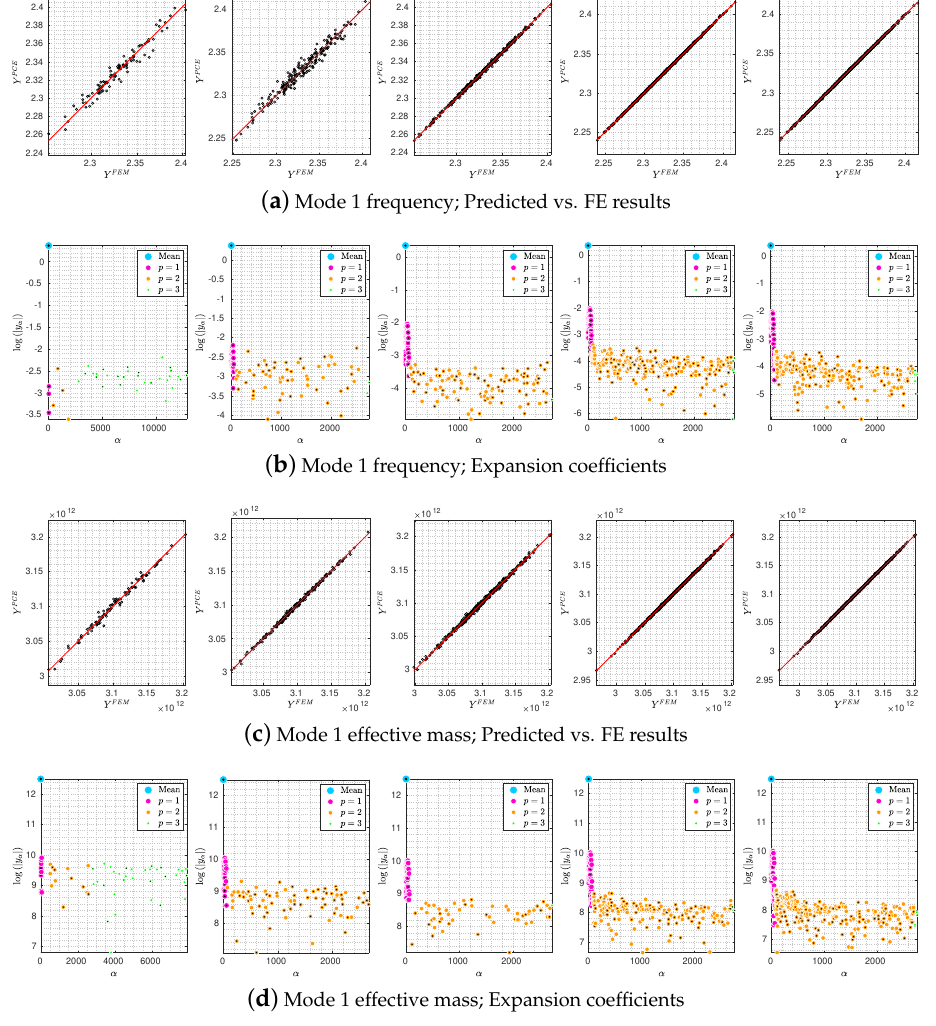
Figure 4. Dam-1; Polynomial Chaos Expansion (PCE)-based surrogate models for varying number of initial DOEs = 100, 200, 400, 800, and 1000 (left to